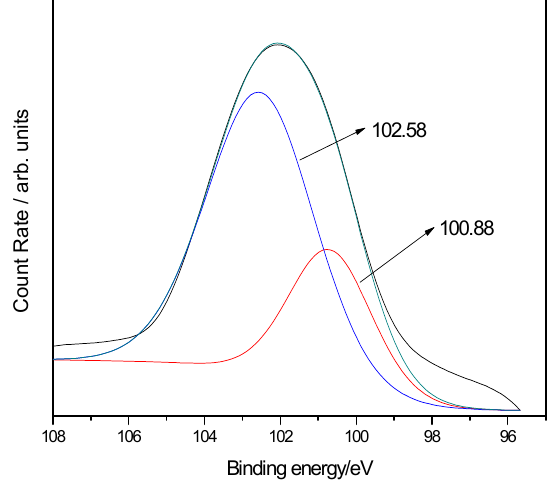
Figure 7. XPS spectra of electrospun xylan/TiO 2 fibers (a, 10%; b, 30%).